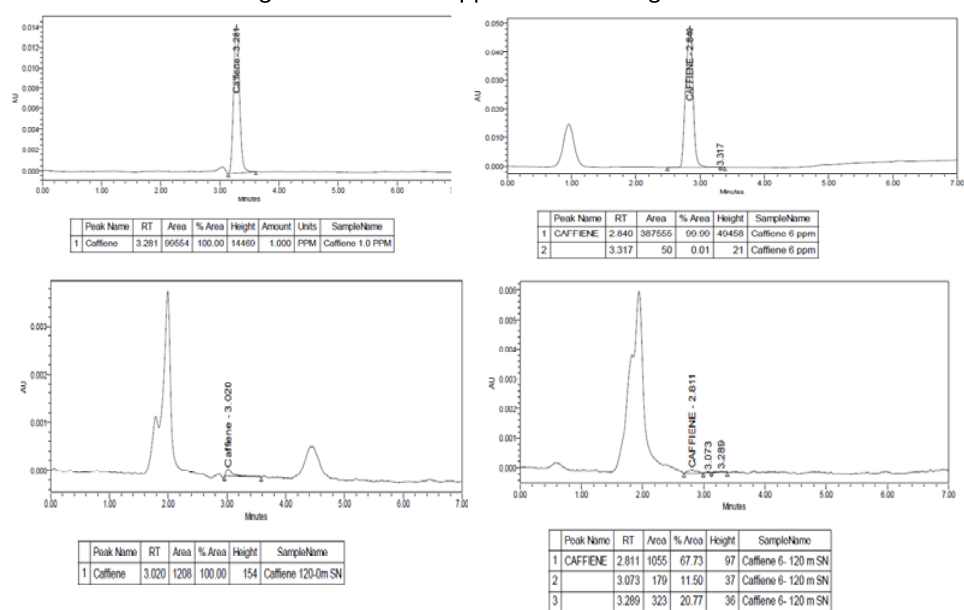
Fig. 5. HPLC Chromatograms of Caffeine standard solution and reaction mixture